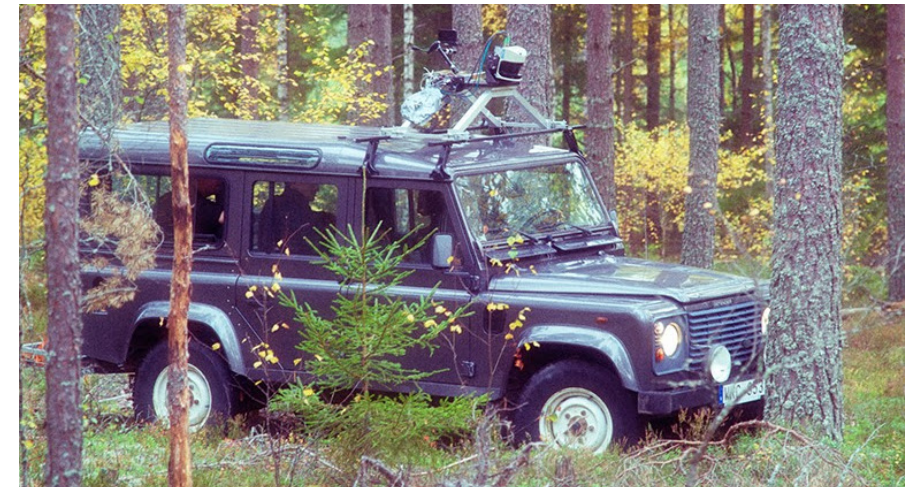
Figure 1. SICK LMS 511 line laser scanner mounted on a terrain car together with the Chameleon positioning system. The laser scanner is mounted facing forward, with an declination of 9 degrees.